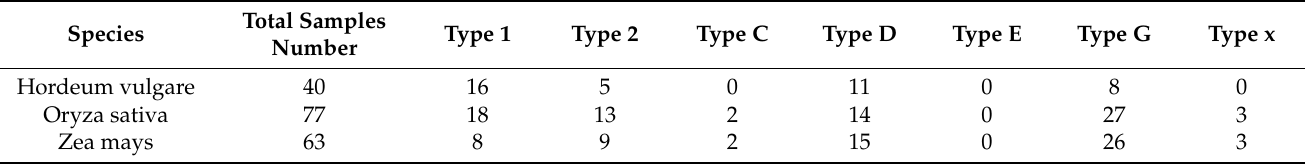
Table 2. Numbers of nsLTP genes in different